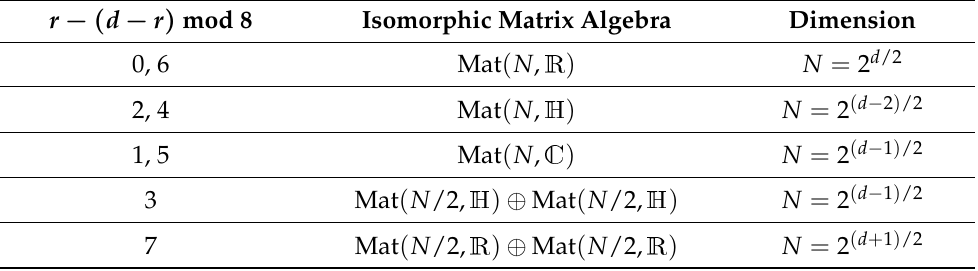
Table 3. Classification of real Clifford algebras C l ( r , d − r , R ) in terms of isomorphic real, complex or quaternionic matrix